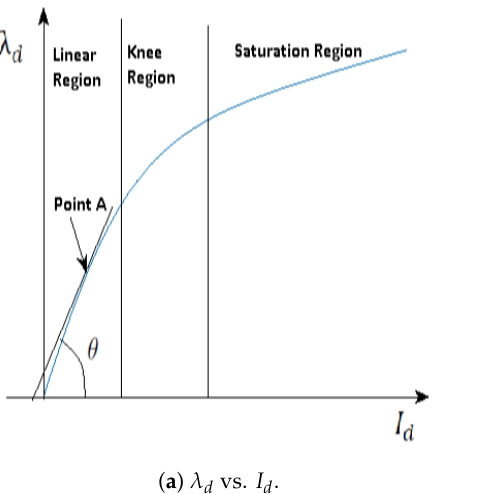
Figure 2. Saturation and corresponding incremental inductance